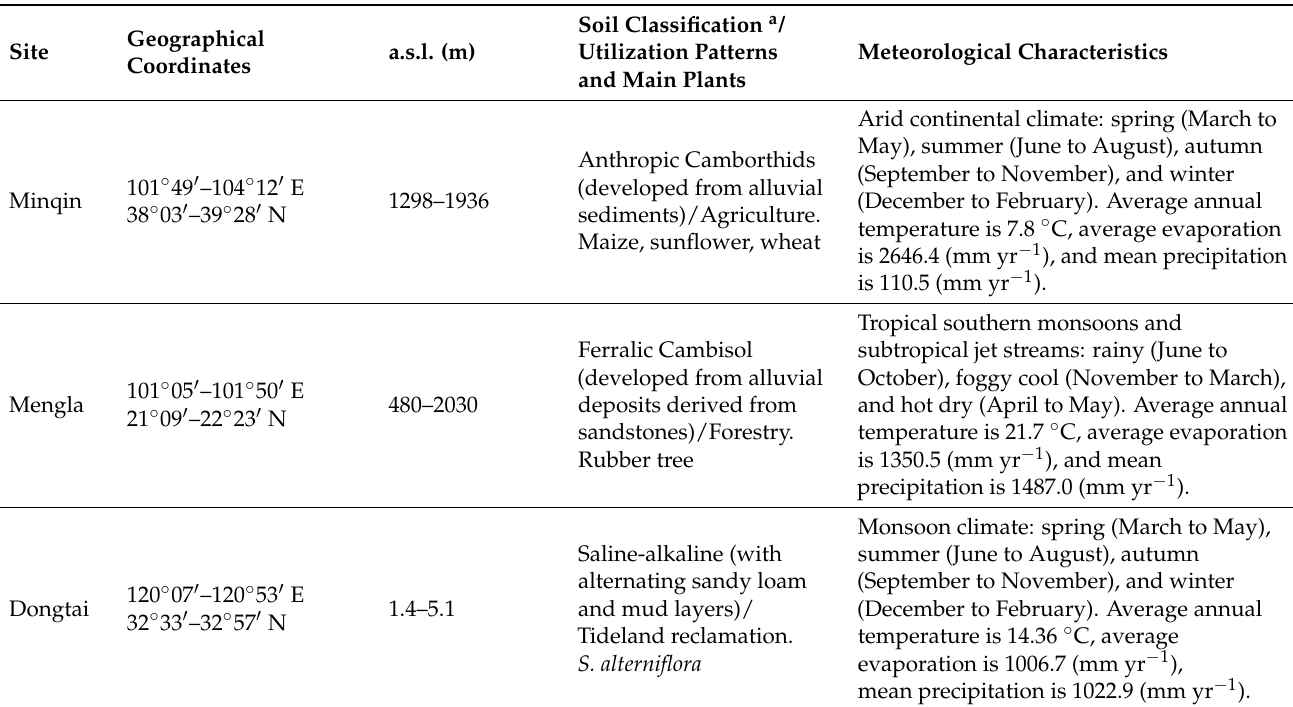
Table 2. Geographic locations and basic properties of experimental